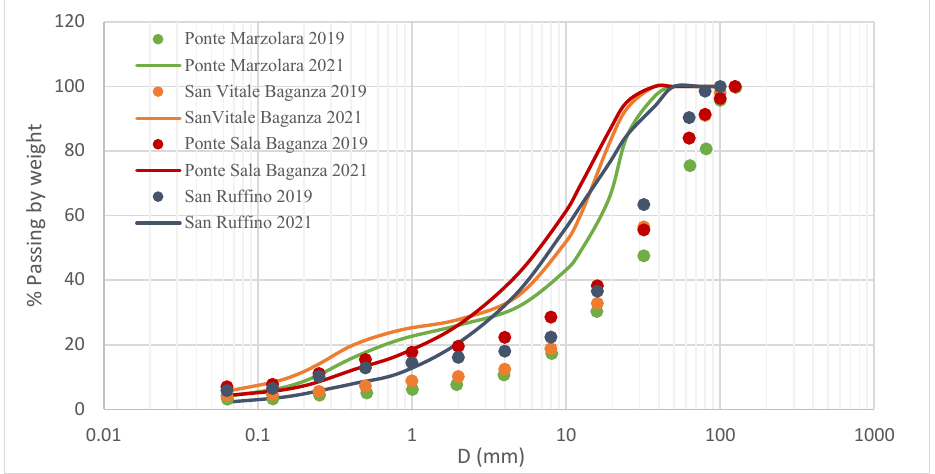
Figure 11. A comparison of the sediments in the subsurface layer from the years 2019 and 2021 at all sections (sieve analysis).